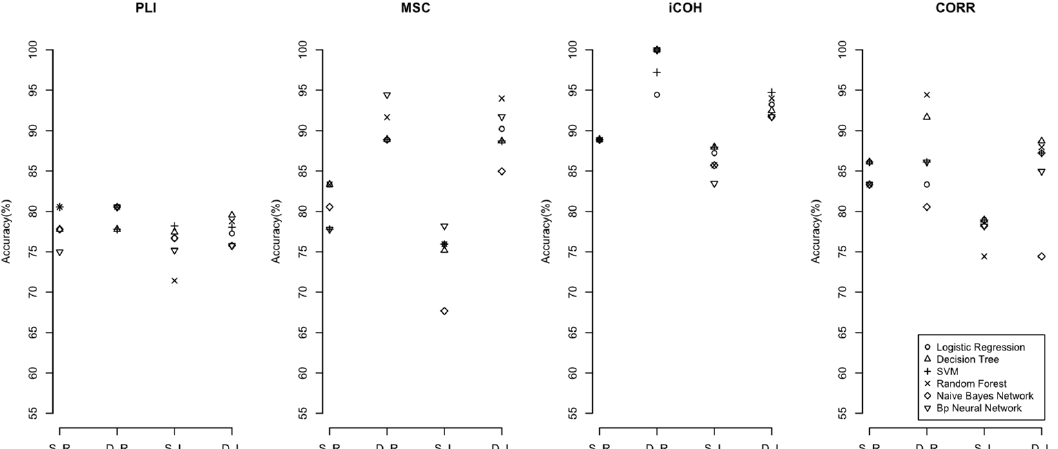
Figure 5. The accuracy of machine learning classifier with significant features under the full-frequency band (S: static network; D: dynamic network; L: split segment EEG signals dataset; R: original sequence EEG signals dataset; PLI: phase delay index; MSC: amplitude squared coherence; iCOH: coherence function Imaginary part; CORR: Pearson correlation coefficient).